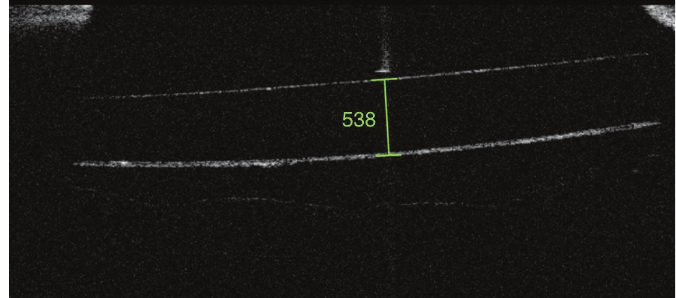
Figure 1. Representative image of IOL thickness measurement method using anterior segment OCT.